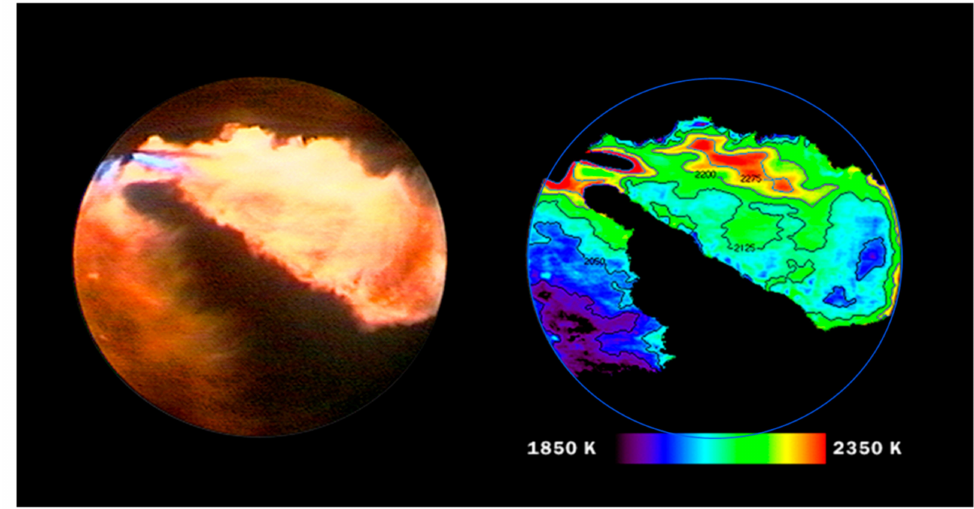
Figure 7. Diagram of methods used to determine combustion temperature